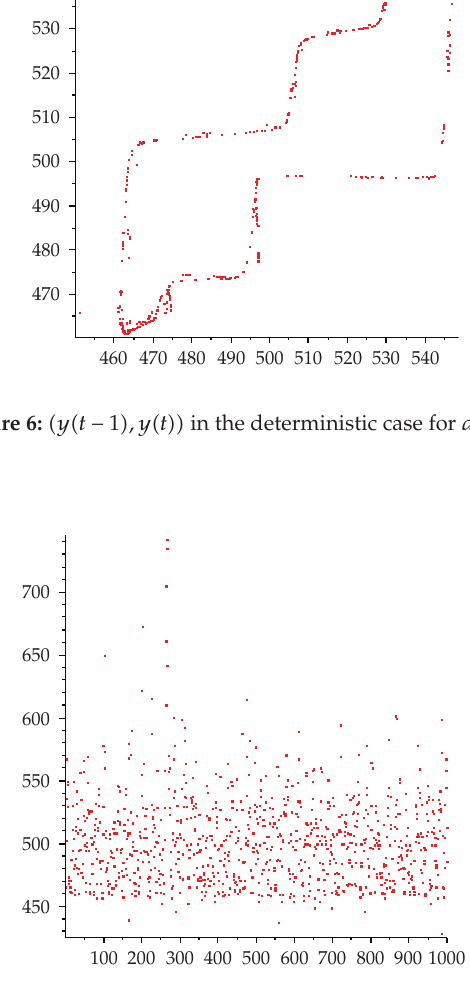
Figure 7: (cid:2) t,y (cid:2) t (cid:3)(cid:3) in the stochastic case for d (cid:7) 0 .